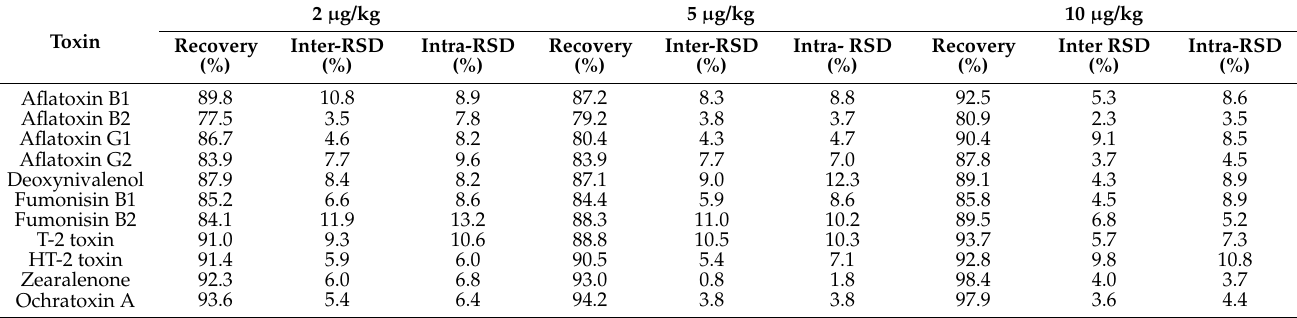
Table 5. Recovery and precision of different mycotoxins spiked in maize ( n = 6).